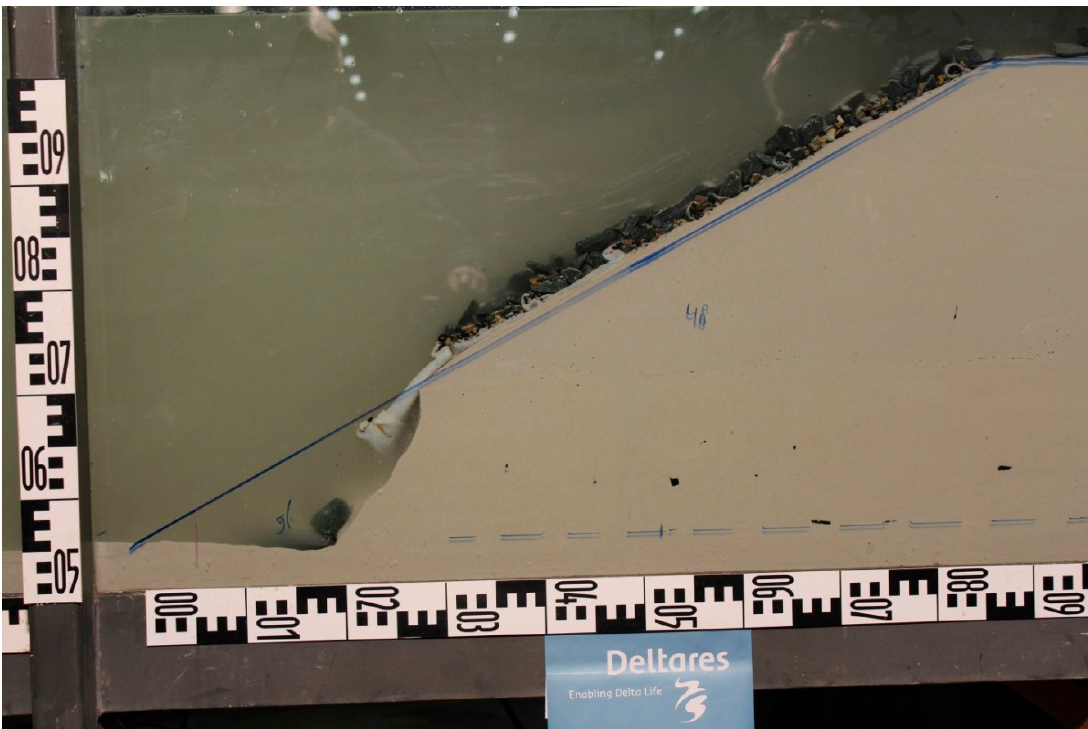
Figure 16. Model test of breaching under a slowly collapsing rock slope protection consisting of a filter layer of fine and coarse gravel on a permeable geotextile membrane. Deltares, 2018 [66]. Photo: M. M. Busink.